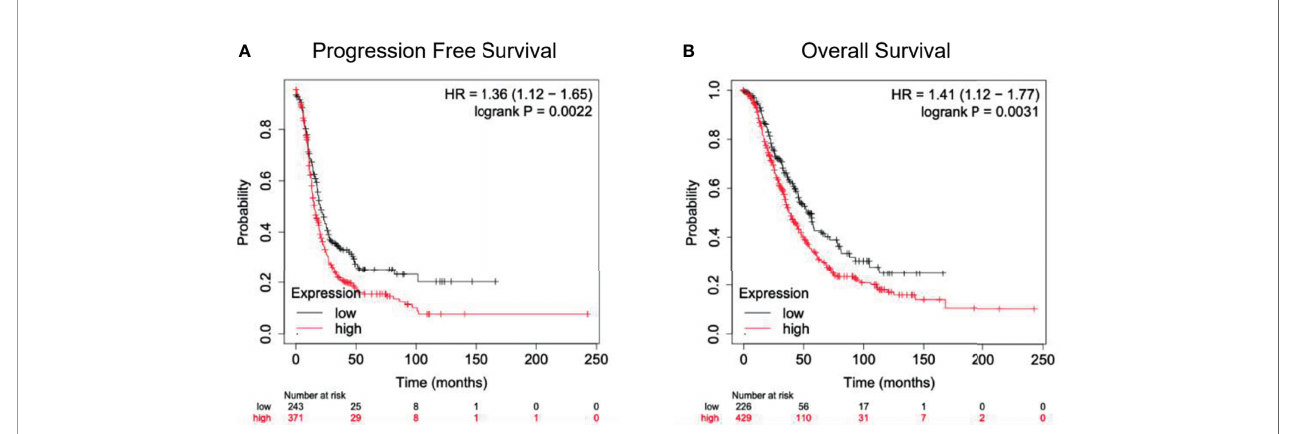
FIGURE 3 | (A) Progression-free survival curves from the date of treatment according to SCN9A expression. (B) Overall survival curves from the date of treatment according to SCN9A